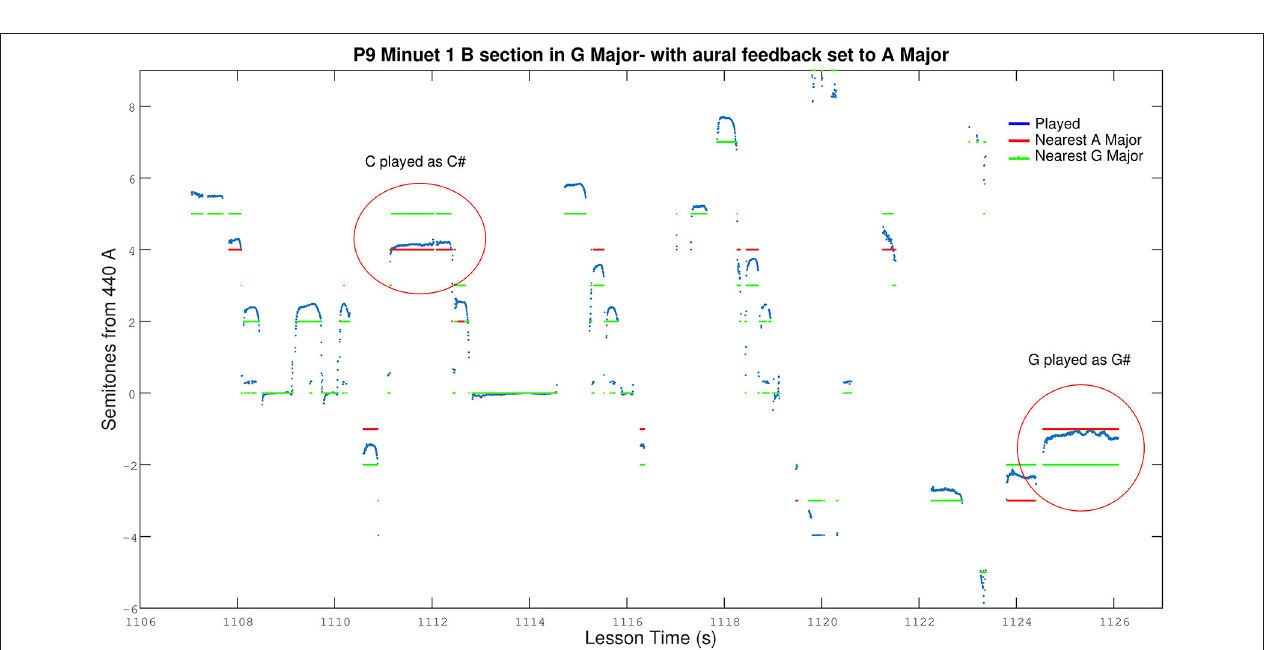
FIGURE 5 | Score to Bach’s Minuet 1 (arr. Seely-Brown). The piece begins with an A section in G Major. The second section, B, is composed of a section in D Major followed by one in G Major. A red bar marks the change in key along with starts and ends of sections.